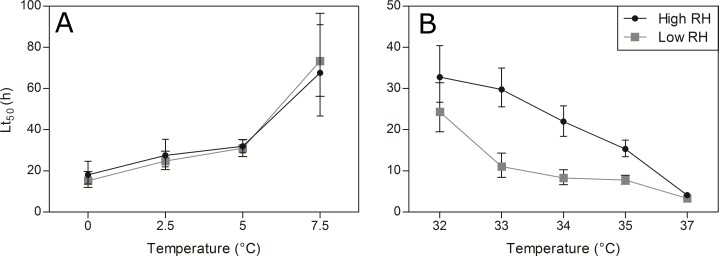
Pupal Lt50 values at low and high temperatures under two relative humidity (RH) levels.Lt50 values ± 95% confidence interval values for low (A) and high temperatures (B). Lt50values are calculated from previous GLM predictions.